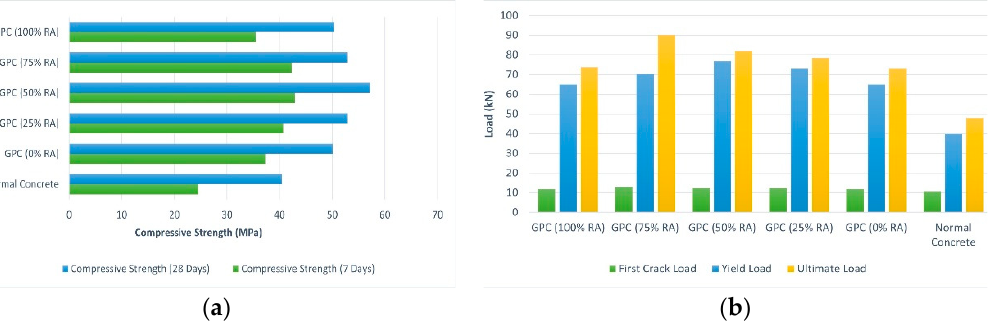
Figure 7. ( a ) The compressive strength of cylindrical specimens with different percentages of RA after 7 and 28 days; ( b ) the load-carrying capacity of beams at various RA replacement ratios [19].